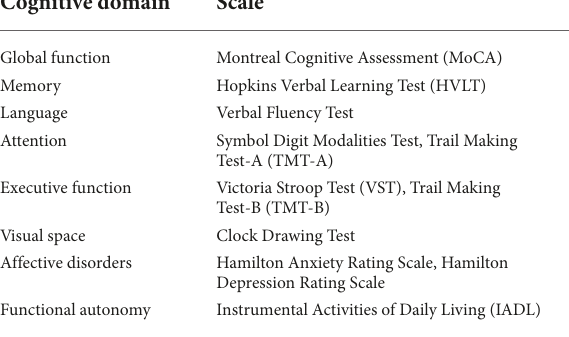
TABLE 1 The battery of neuropsychological